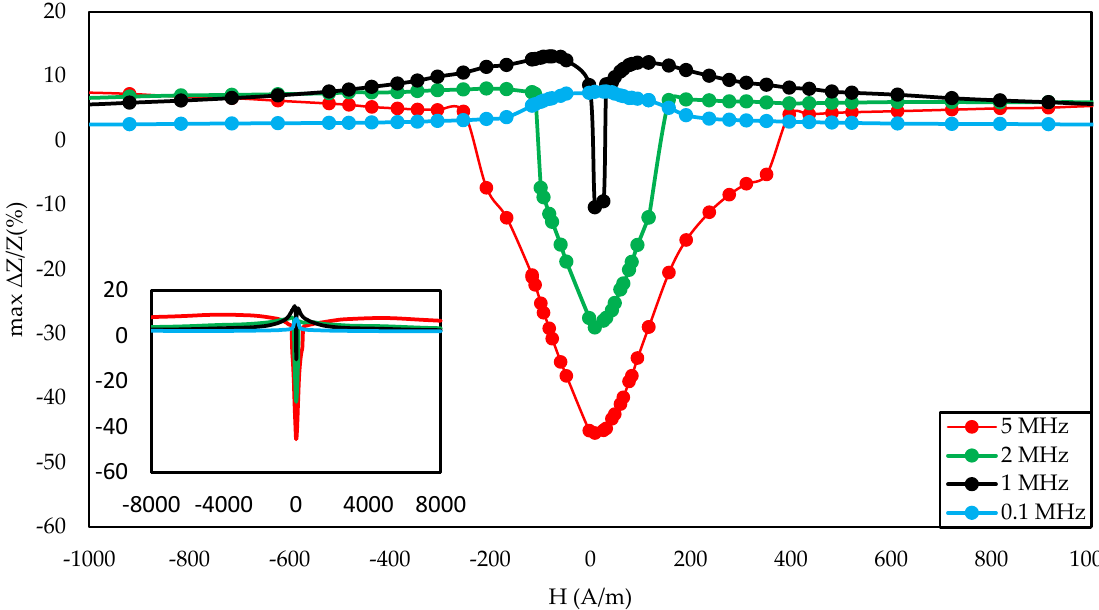
Figure 5. Dependence of max change of impedance ratio in a function of magnetizing field for different driving frequencies for the as-cast sample.